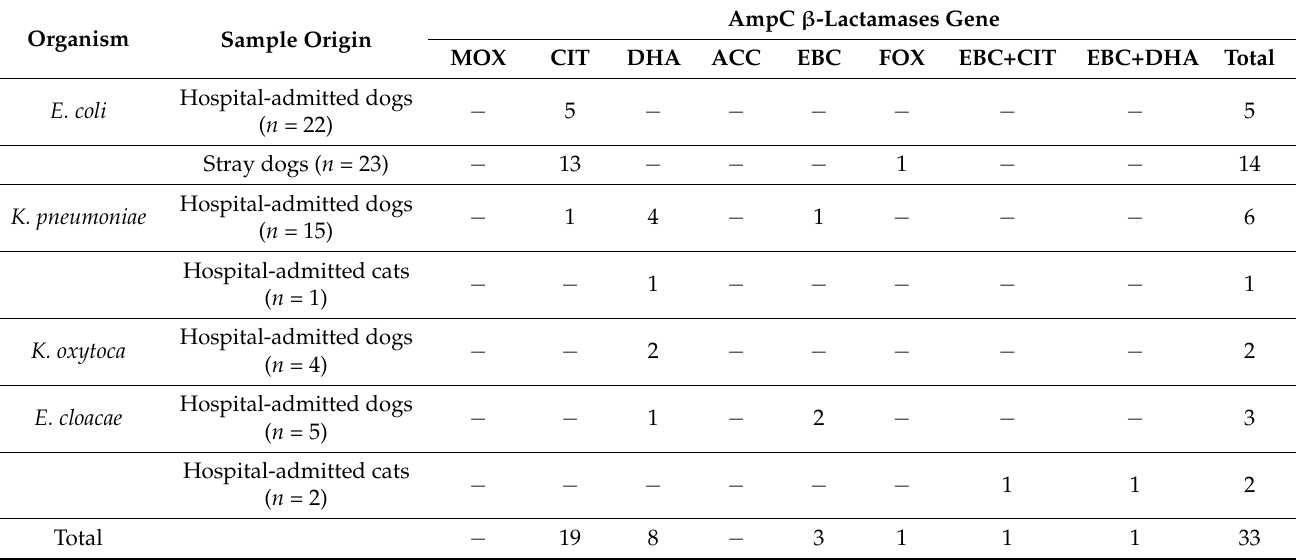
Table 3. Distribution of AmpC β -lactamase genes among ESBL-producing Enterobacterales isolates.